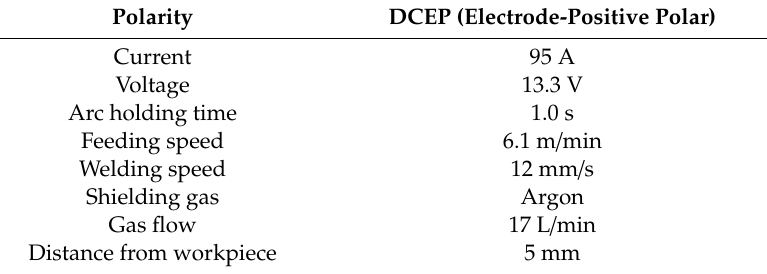
Table 2. Parameters applied during the welding